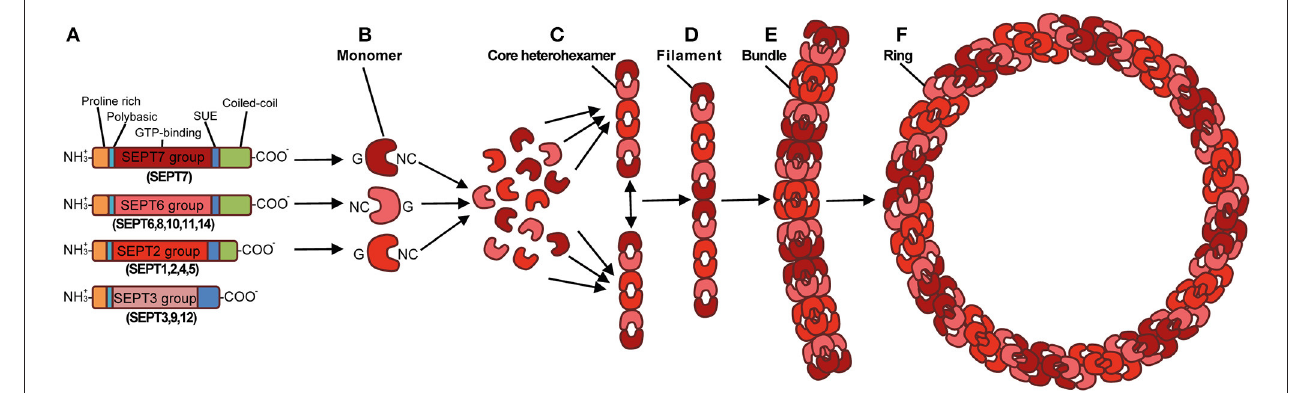
FIGURE 1 | Structure and assembly of the septin cytoskeleton. (A) Prototypical structure of mammalian septins. Humans septins (SEPT1–SEPT12, SEPT14) are classified into four subgroups (SEPT2, SEPT3, SEPT6, SEPT7), and consist of three conserved domains: a phosphoinositide-binding polybasic region, a GTP-binding domain, and a septin unique element (SUE). Septins typically have a proline-rich motif at the amino-terminal and a coiled-coil domain at the carboxy-terminal, although the length of these regions varies. By interacting via their G and NC interfaces, septin monomers (B) from different subgroups (shown as different shades of red), form complexes (rods of 32–40nm in length) that contain six (C) or eight (not shown) symmetrically arranged septins (2 monomers from each septin subgroup). When complexes are assembled end-to-end they form non-polar filaments (D) . Septin filaments can associate laterally and form bundles (E) , bundles of septin filaments can form higher-order structures, such as rings which are ∼ 0.6 µ m in diameter (F) . Adapted from Mostowy and Cossart